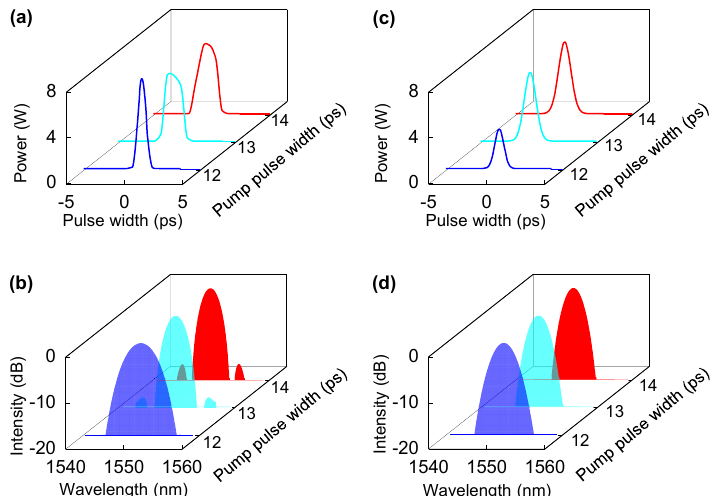
Figure 4. Temporal profile and the corresponding spectrum [( a , b )] without ( γ 1 = γ 2 = γ 12 = γ 21 = 0) and [( c , d )] with ( γ 1 = γ 12 = 0.66 W − 1 m − 1 , γ 2 = γ 21 = 1.32 W − 1 m − 1 ) third-order nonlinearity for the pump pulse width increases from 12 ps to 14